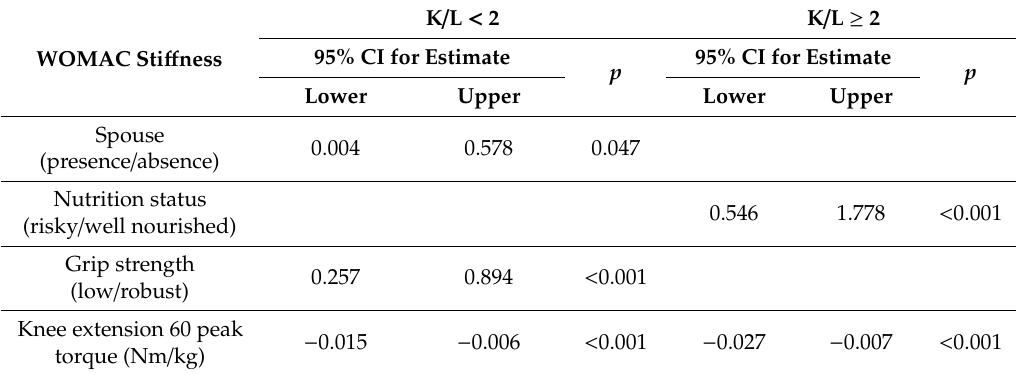
Table 4. Results of stepwise multiple regression analysis for the WOMAC sti ff